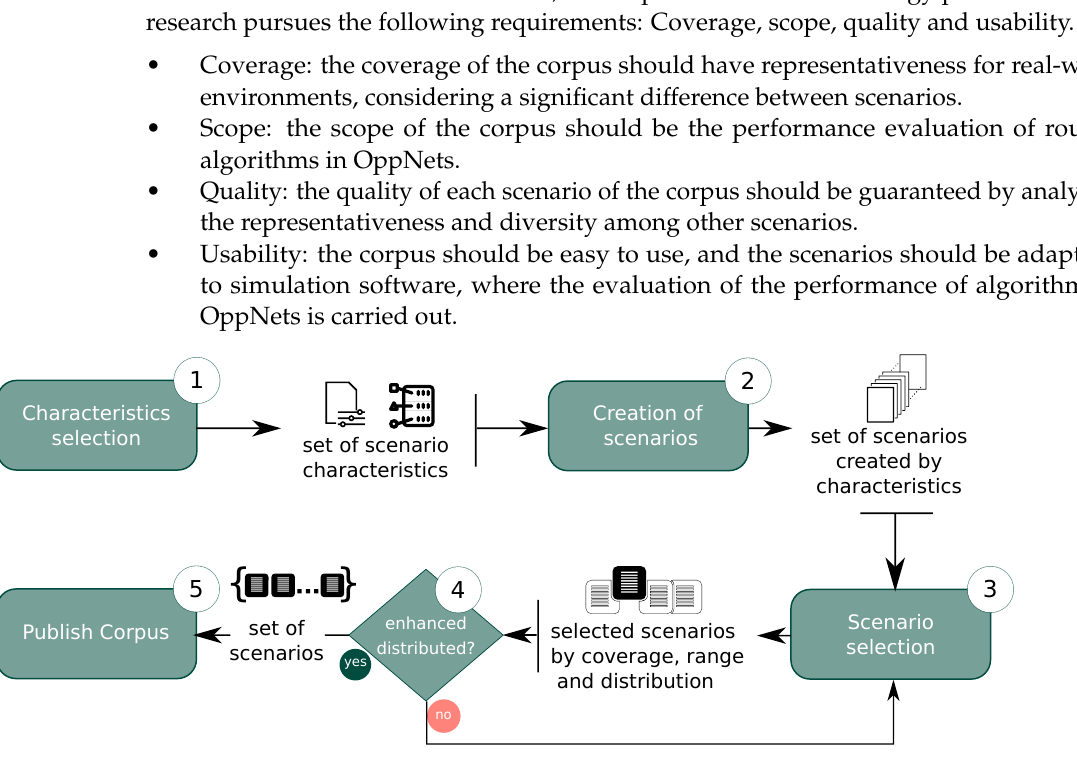
Figure 3. Corpus creation methodology with backtracking stage for scenario selection assuring purpose, coverage, scope, quality and usability